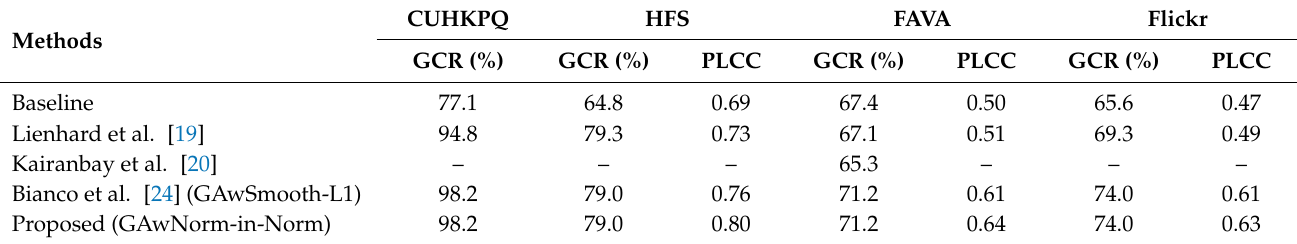
Table 5. Comparison with state-of-the-art methods for both aesthetic categorization and score prediction for all the considered databases. For CUHKPQ, only the binary ground-truth (low-/high- aesthetics) is provided; therefore, the PLCC cannot be estimated.